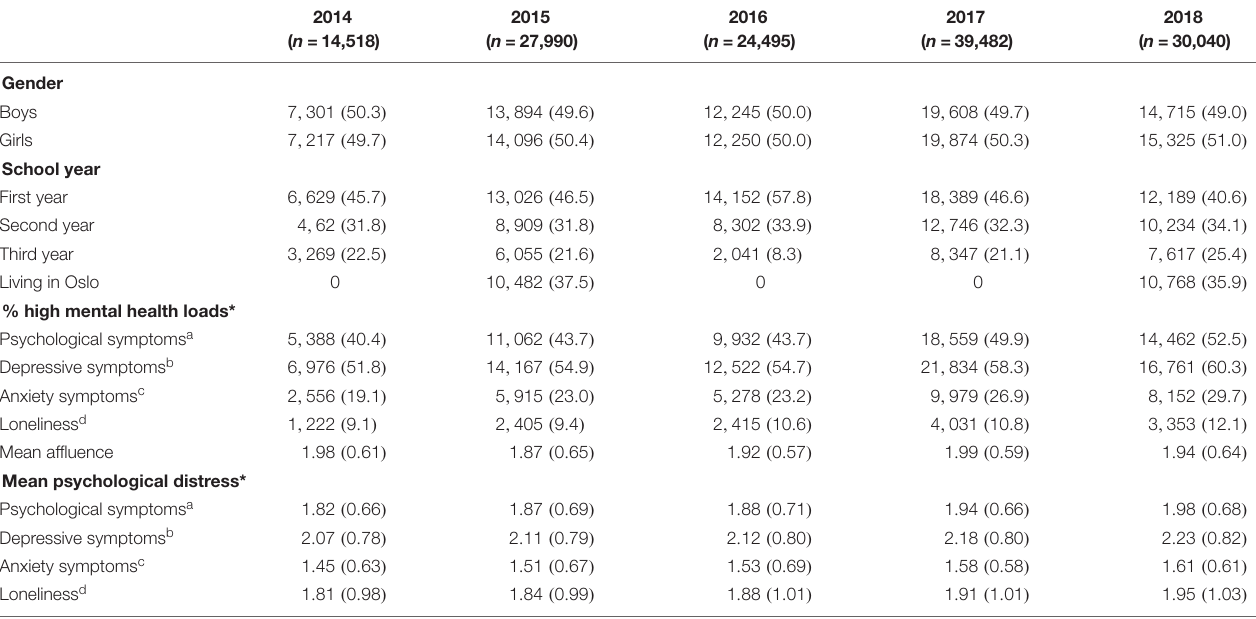
TABLE 1 | Unadjusted sample characteristics ( n = 136,525) by survey